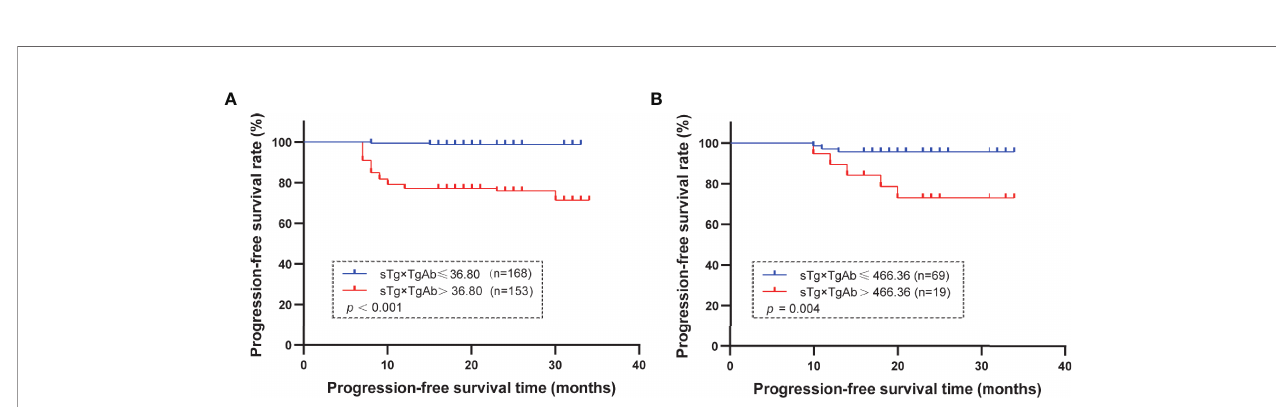
FIGURE 4 | (A) ROC curve for sTg×TgAb product before initial RAIT to predict unsuccessful ablation of the TgAb-negative group. The cutoff for sTg×TgAb product was 36.80 (AUC: 0.937, 95% CI: 0.911 – 0.962) with 87.6% sensitivity and 85.2% speci fi city ( p < 0.001). (B) ROC curves for sTg×TgAb product before initial RAIT to predict the unsuccessful ablation of the TgAb-positive group. The cutoff for sTg×TgAb product was 466.36 (AUC: 0.656, 95% CI: 0.542 – 0.770) with 35.7% sensitivity and 91.3% speci fi city ( p